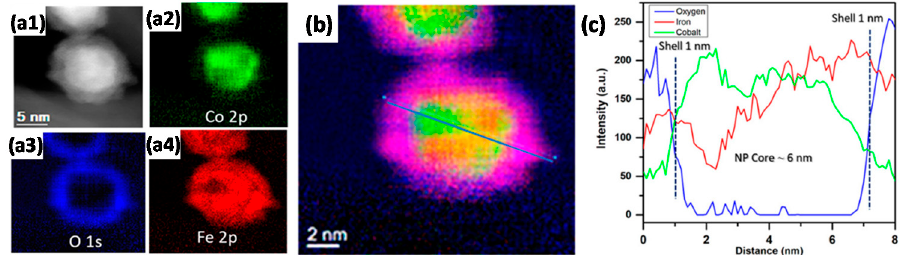
Figure 7. Janus-like CoFe alloy formation in CoFe/CNT FTS catalyst after reduction by H 2 . ( a1 ) HAADF-STEM of CoFe/CNT catalyst; ( a2 )–( a4 ) corresponding EDX elemental mappings of ( a2 ) Co, ( a3 ) O and ( a4 ) Fe. ( b ) Composite red-green-blue elemental mapping of Fe (red), Co (green) and O (blue), with EDX line scan pattern drawn on top. ( c ) EDX line scan profile corresponding to the pattern drawn in ( b ). Adapted with permission from Ref. [118], https://pubs.acs.org/doi/abs/10.1021/acscatal.8b04334. Further permissions related to the material excerpted should be directed to the ACS.